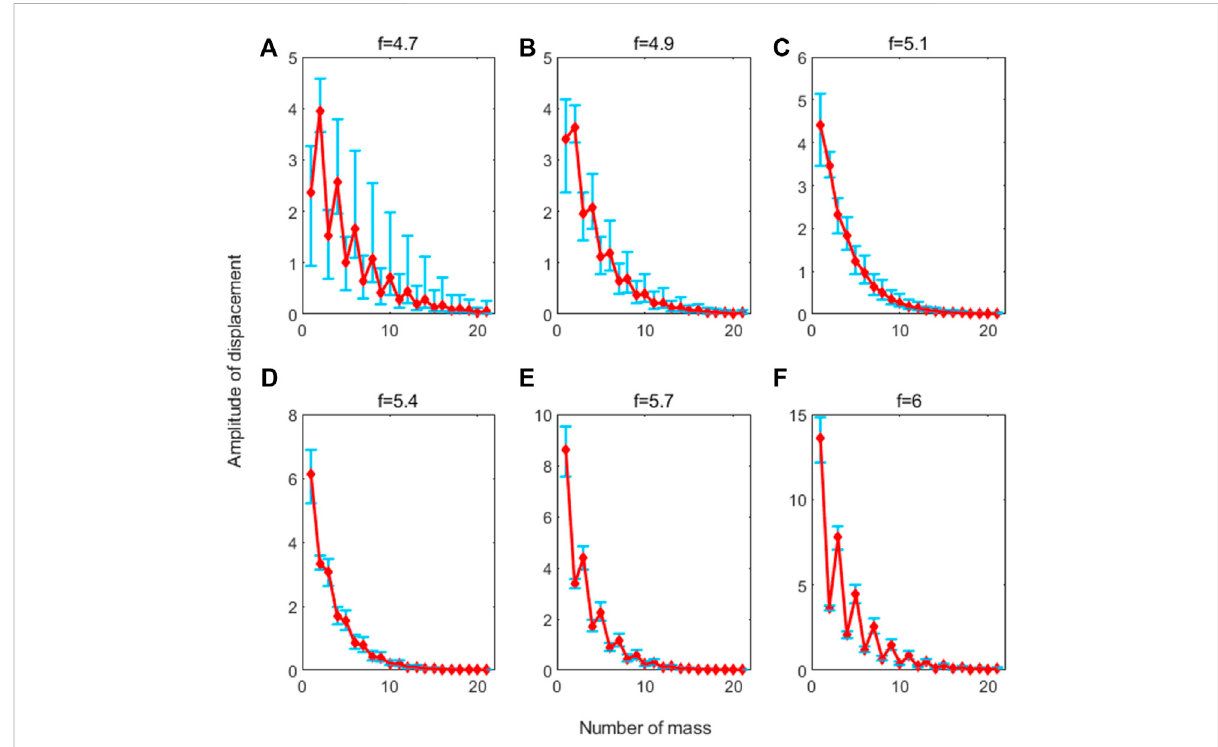
FIGURE 4 Variation of forced response at frequencies: (A) f = 4.7, (B) f = 4.9, (C) f = 5.1, (D) f = 5.4, (E) f = 5.7, and (F) f = 6.